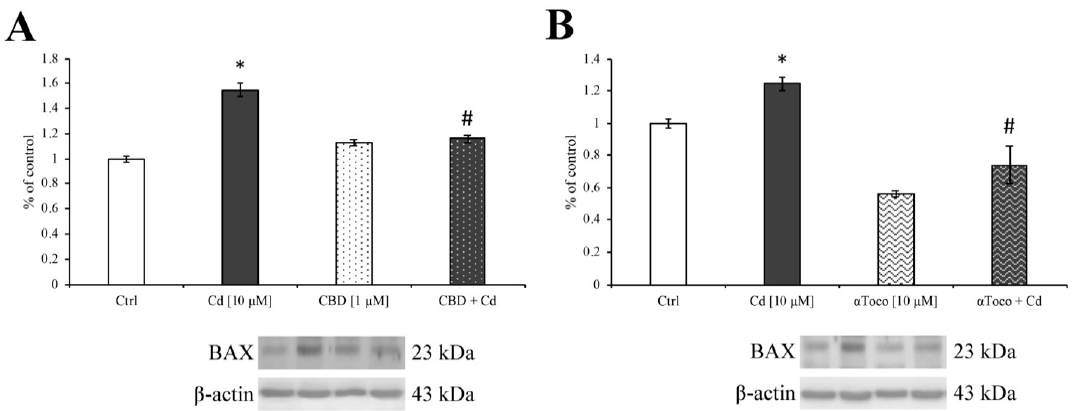
Figure 4. Western blotting analysis on pro-apoptotic protein. Consistent with Cd-induced SH-SY5Y